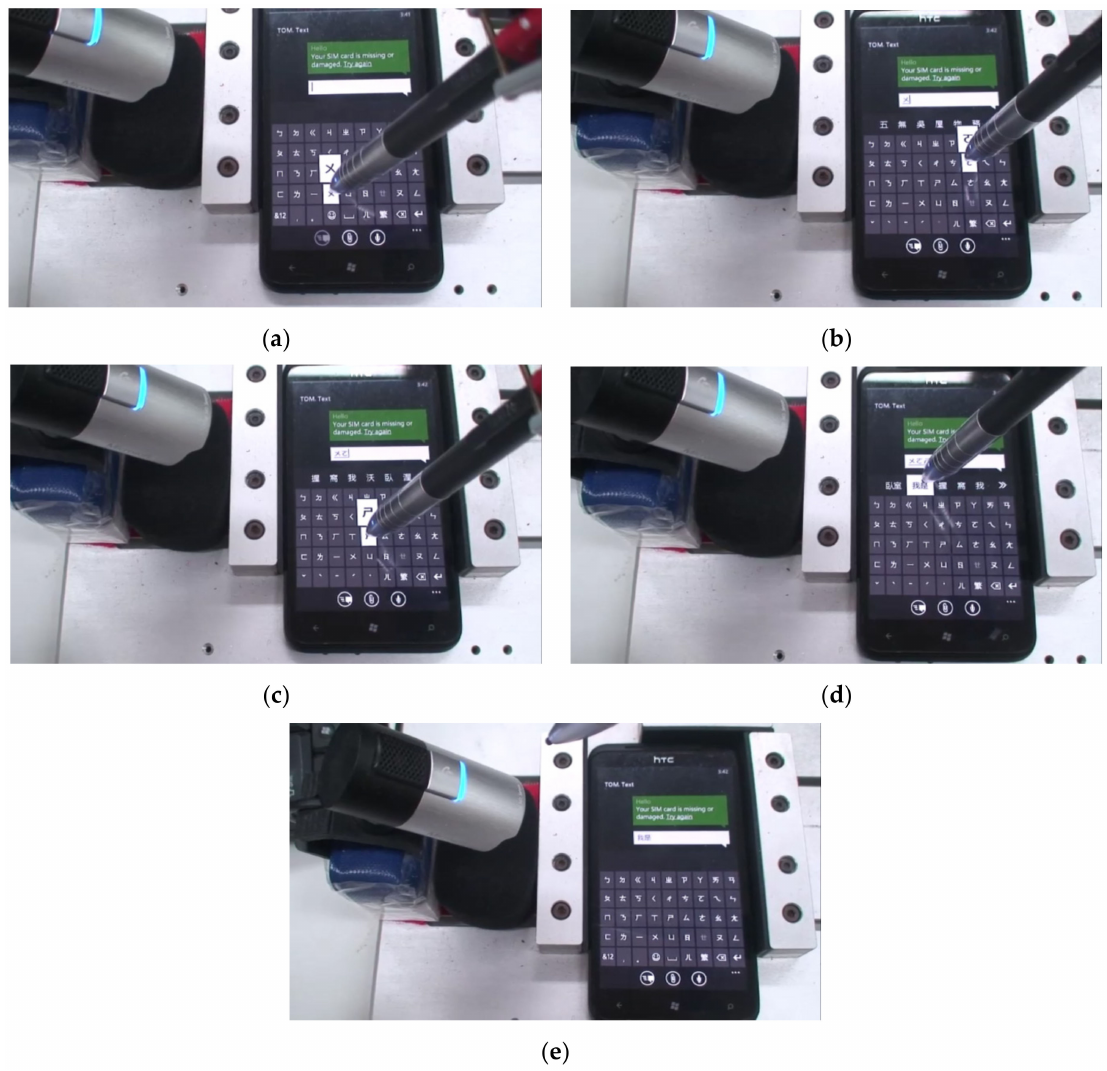
Figure 30. Selection of the right Chinese characters. ( a ) Press symbol “ ㄨ ”. ( b ) Press symbol “ ㄛ ”. ( c ) Press symbol “ ㄕ ”. ( d ) Press characters “ 我 是 ” but not “ 室 ”. ( e ) Confirm